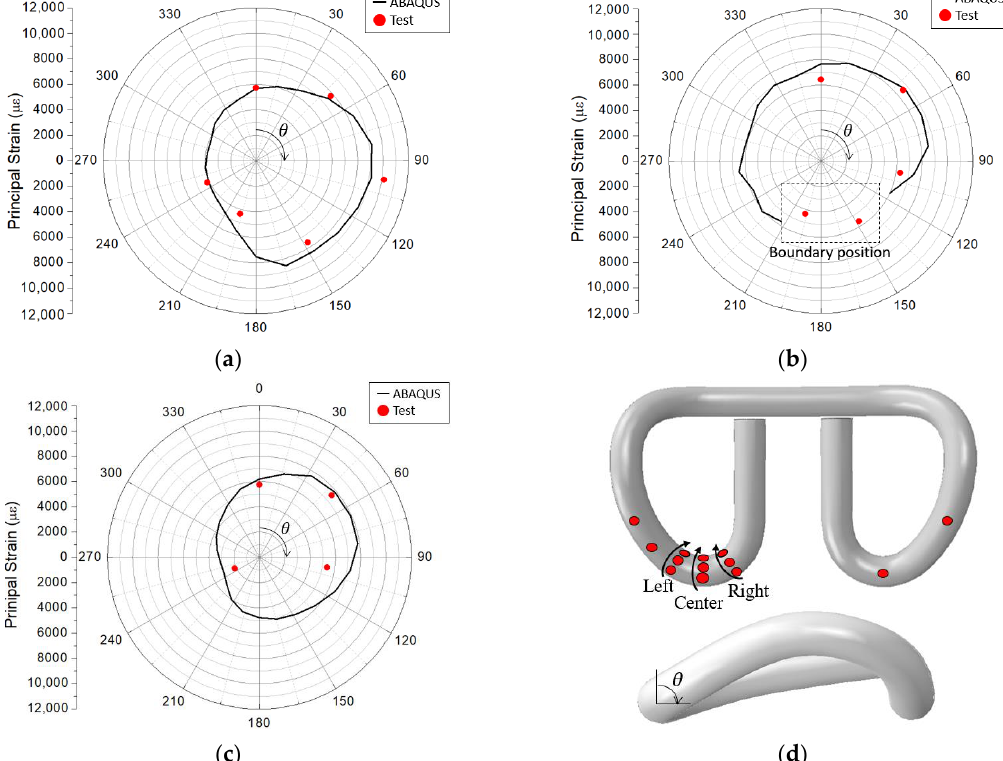
Figure 9. Loading steps of finite element analysis.